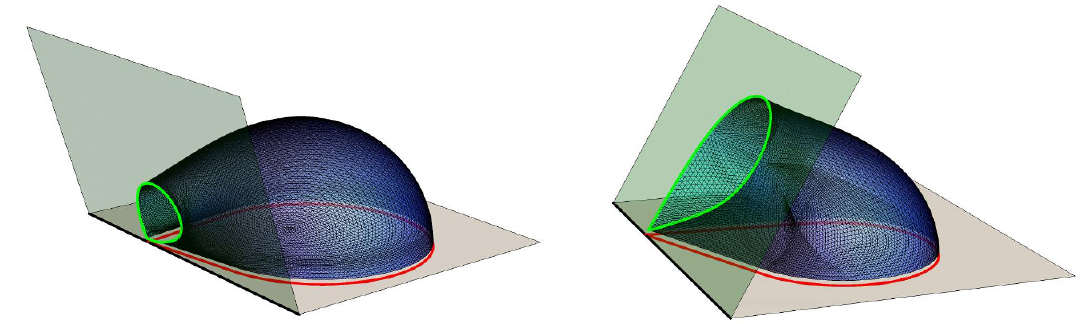
Figure 19 . Minimal surfaces ^ (cid:13) A obtained with Surface Evolver and corresponding to a single drop A such that the entangling curve @A (solid red curve in the z = 0 grey half plane) intersects the boundary at the tip of its corner. For these con(cid:12)gurations of A , the corresponding minimal surface is the surface which intersects Q (green half plane) orthogonally along the green curve. In the left panel (cid:11) = (cid:25)= 2 : 5, ! = (cid:25)= 2, (cid:13) = (cid:25)= 2 (cid:0) (cid:25)= 5 and L = 0 : 75, while in the right panel (cid:11) = 2 (cid:25)= 3, ! = (cid:25)= 3, (cid:13) = (cid:25)= 2 (cid:0) (cid:25)= 5 and L = 1. In both panels " = 0 :